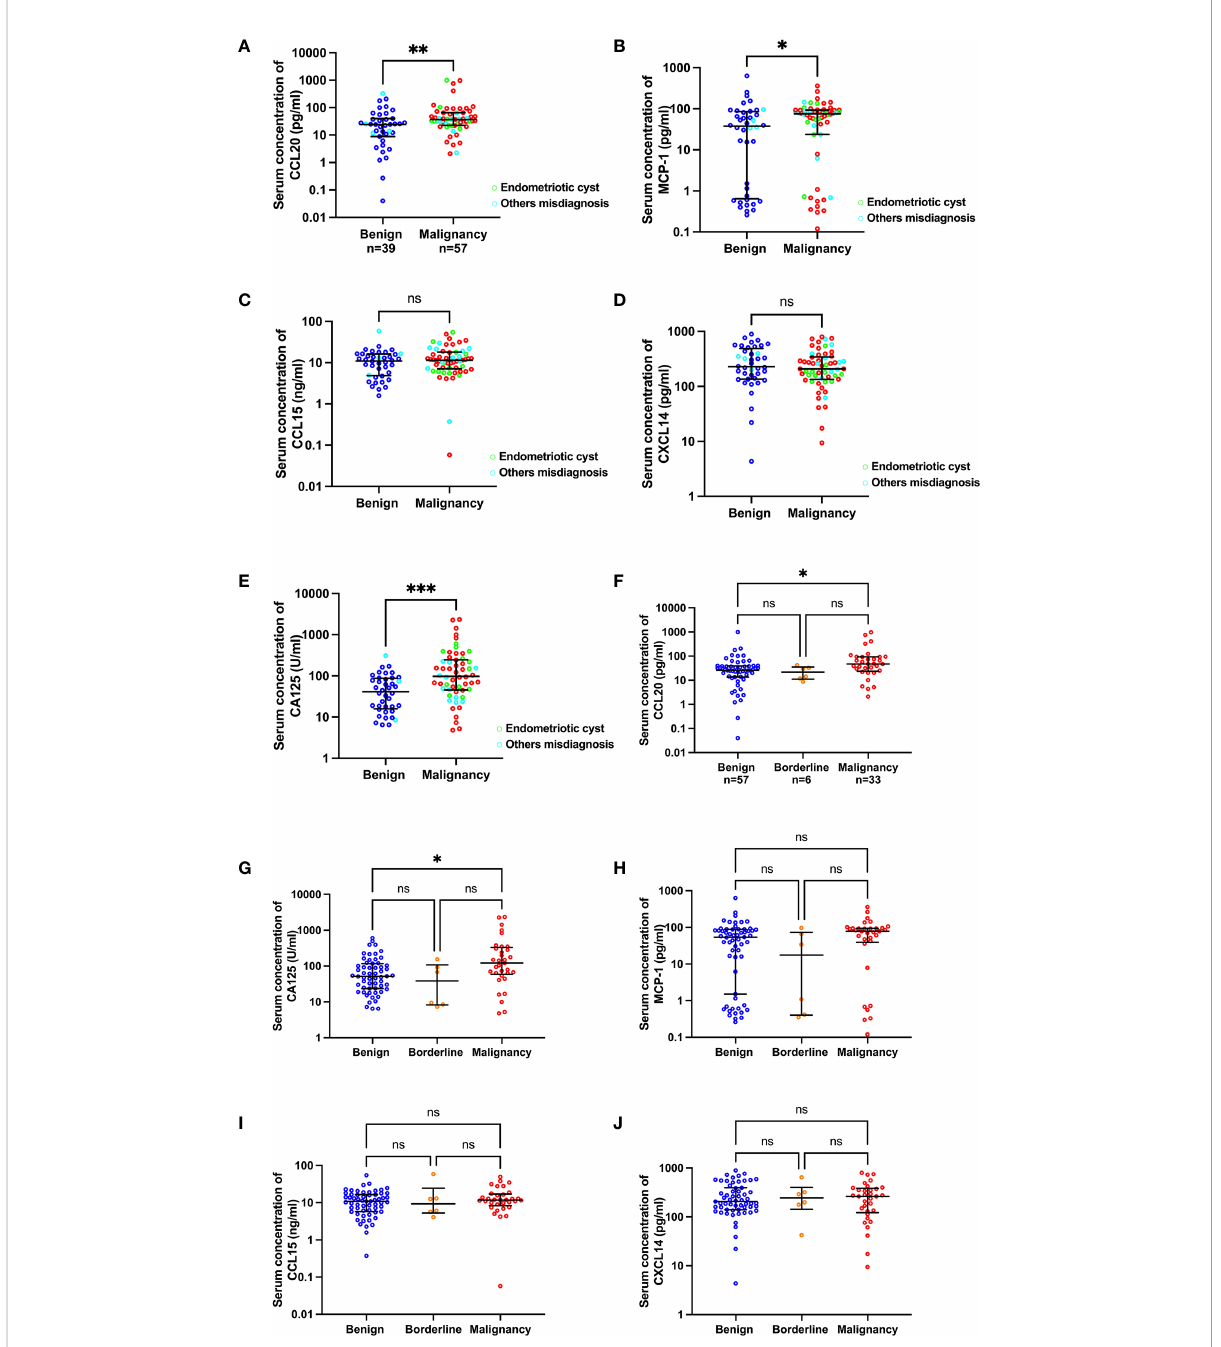
FIGURE 1 Scatter plots of CA125 and chemokine concentrations categorized by preoperative diagnosis (A – E) and pathological diagnosis (F – J) . The green and cyan circles in (A – E) indicate preoperatively misdiagnosed cases of endometriotic cyst and others, respectively.*p<0.05; **p<0.01; ***p<0.001; not signi fi cant (ns). The lower and upper whiskers are interquartile ranges, and the middle line is the